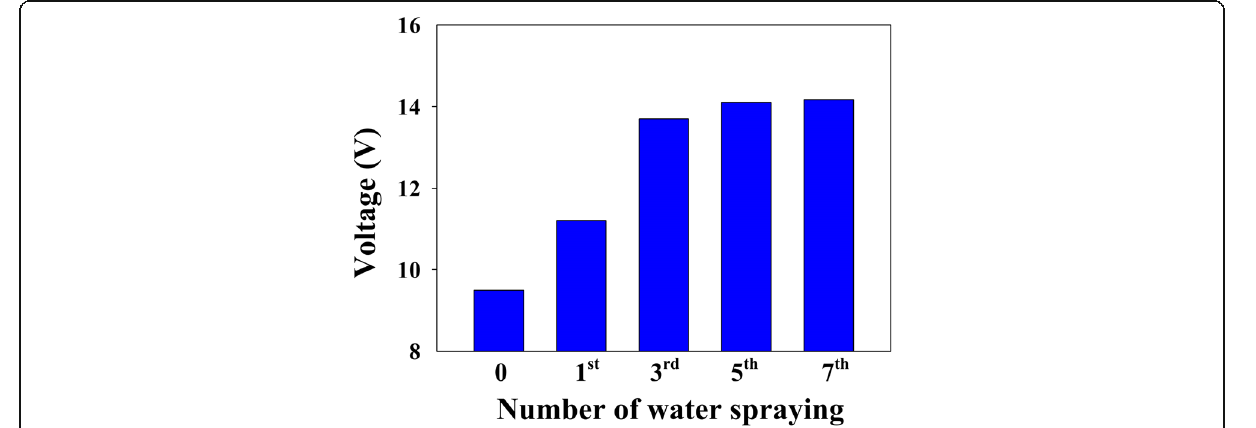
Fig. 5 Dependence of the output voltage on the number of water spray steps